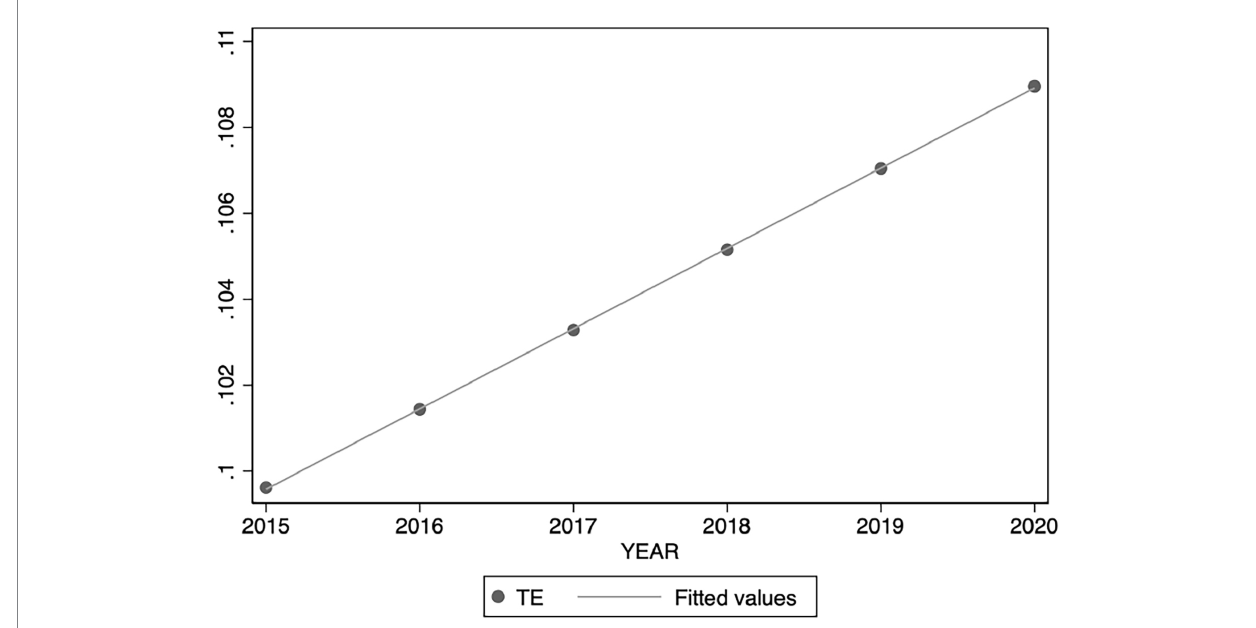
FIGURE 2 Average innovation efficiency of Chinese pharmaceutical-listed companies from 2015 to